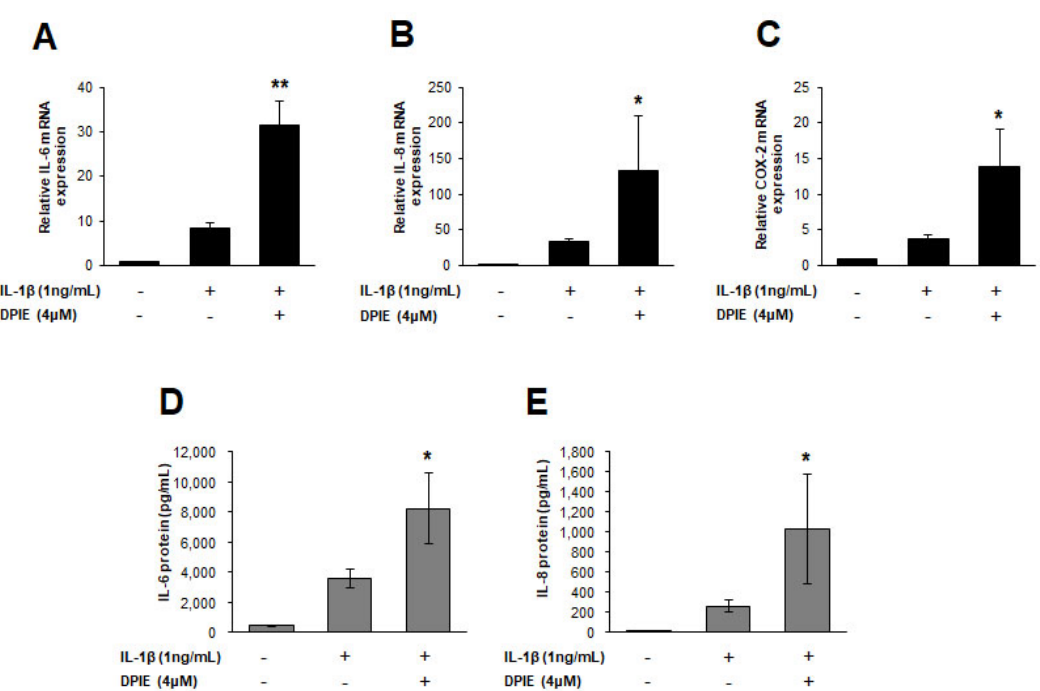
Figure 4. DPIE enhances pro-inflammatory cytokine expression in IL-1 β -stimulated human periodontal ligament cell (hPDLs). hPDLs were treated for 12 h with 4 µ M DPIE in the absence or presence of 10 ng/mL IL-1 β , and then mRNAs and supernatants were analyzed using real-time PCR and ELISA, respectively. ( A – C ) DPIE enhances IL-6, IL-8, and COX-2 mRNA production in IL-1 β -stimulated hPDLs. ( D , E ) DPIE enhances IL-6 and IL-8 protein production in IL-1 β -stimulated hPDLs; * p < 0.05 and ** p < 0.01 compared with IL-1 β alone (unpaired two-tailed Student’s t tests).